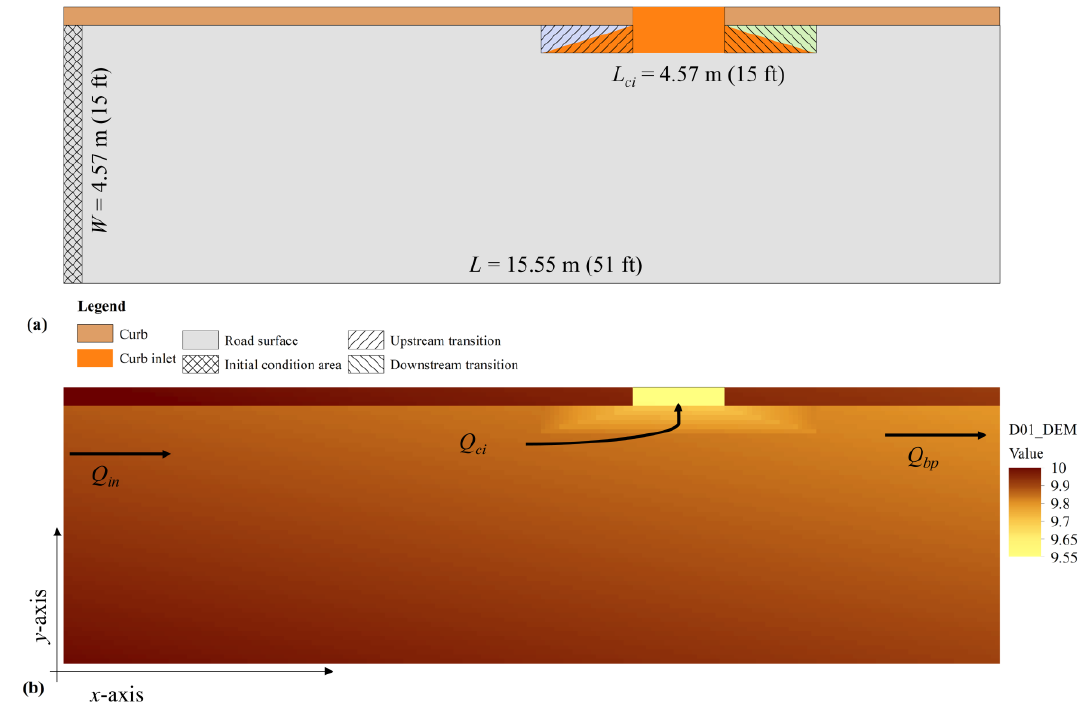
Figure 1. ( a ) Layout of the Type D curb inlet evaluation experiment, and ( b ) digital elevation model (DEM) of case D01 with S 0 = 0.004 and S x = 0.0208.